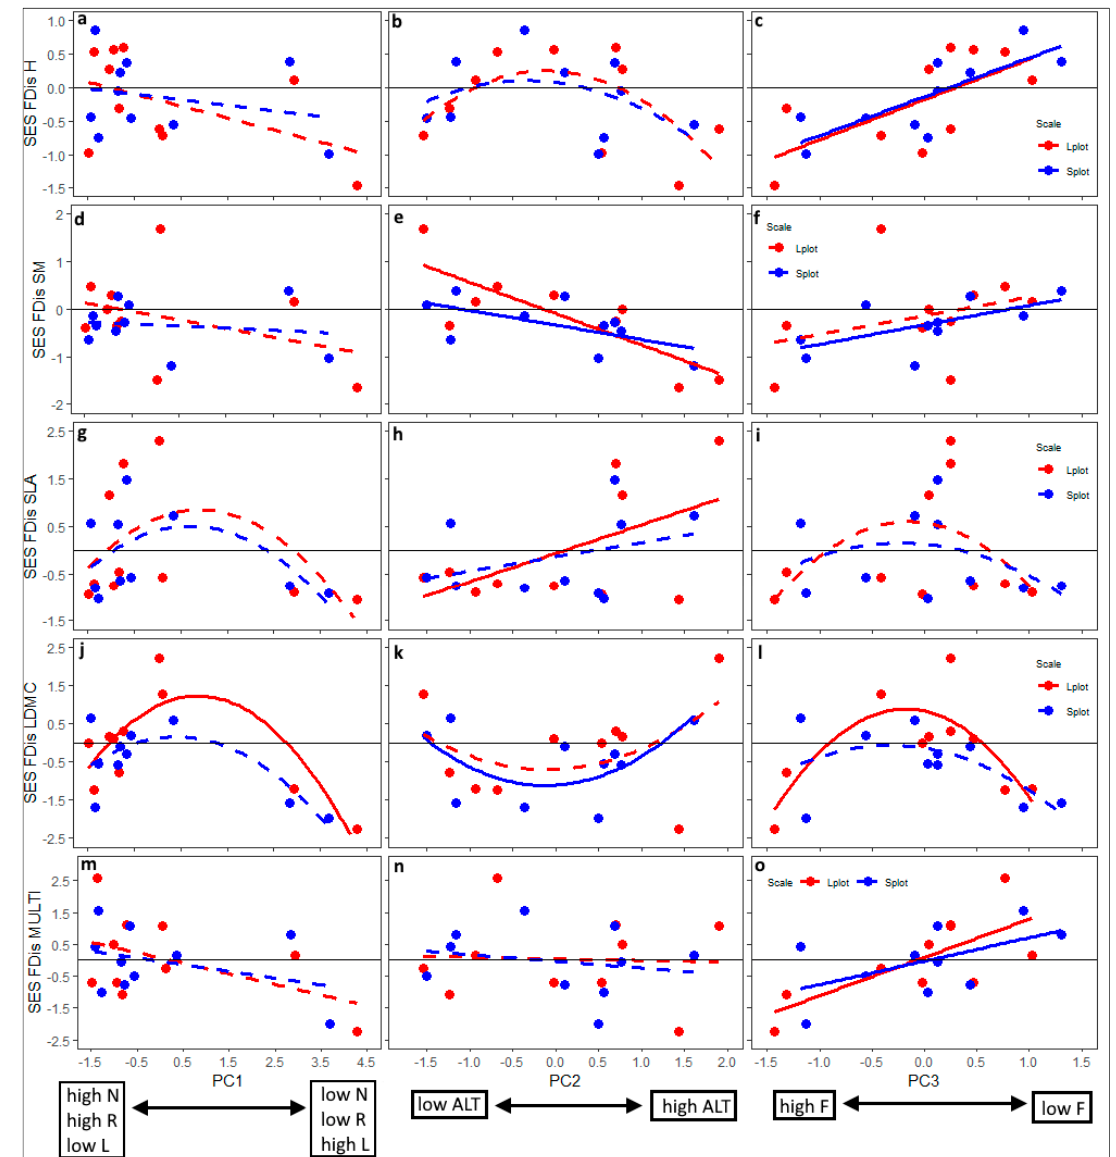
Figure 4. Standardized effect size (SES) of functional dispersion (FDis) for four functional traits (H—plant height, SM—seed mass, SLA—specific leaf area, LDMC—leaf dry matter content) and their multivariate combination (MULTI) along three environmental gradients (PC1 = gradient related to nutrient availability (N), soil reaction (R) and light availability (L); PC2 = altitudinal gradient (ALT); PC3 = gradient in soil moisture (F)). Values on the X-axis are average site-level ( n = 10) scores derived from PCA ordination. Red data points represent large plots (Lplot, 10 × 10 m) and blue dots represent small plots (Splot, 2 × 2 m). Significant regressions ( p < 0.05) are indicated with solid lines. SES values higher than 0 (solid horizontal line) suggest trait divergence, whereas SES values lower than 0 suggest trait convergence.